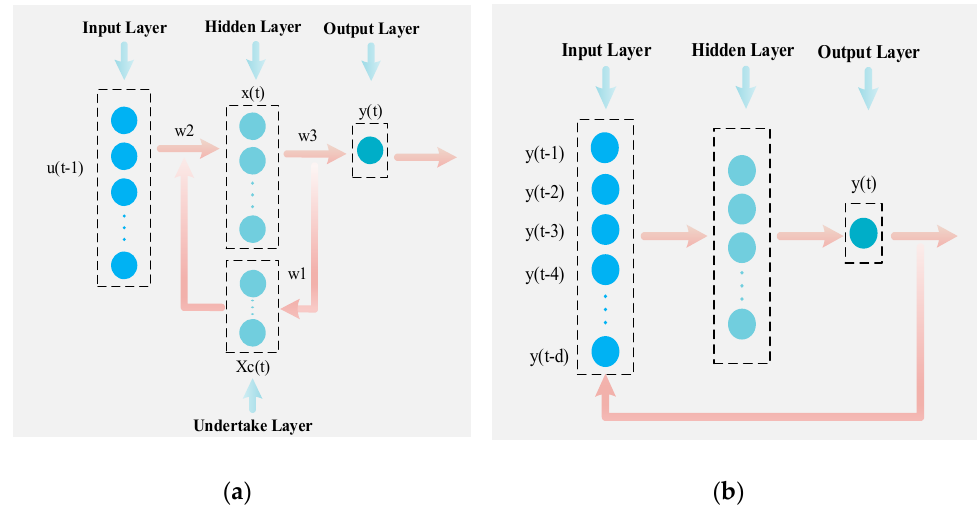
Figure 3. ( a ) Elman neural network model, ( b ) NAR network architecture